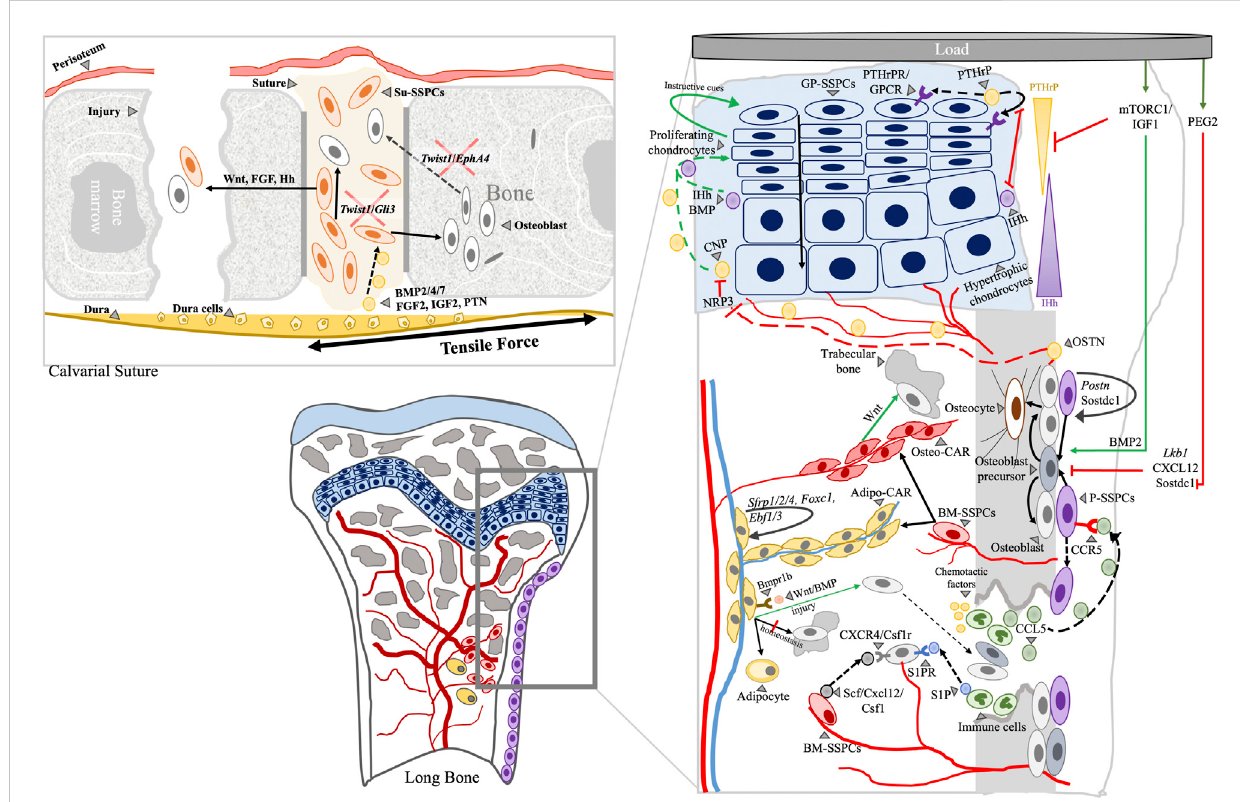
FIGURE 4 Schematic representation of plausible interactions of cellular components and molecular regulators at various skeletal compartments during bone remodeling and aging. Calvarial and long bone skeletal compartments are shown. Arrowhead: label; Black solid arrow: fate; Black dashed arrow: movement/migration; Red line: negative regulation; Green arrow: positive regulation; Arrows indicate directions of interactions or positive